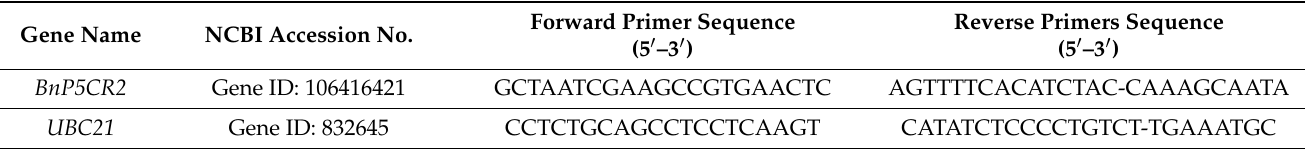
Table 2. The primers of target gene and internal reference gene for RT-qPCR.